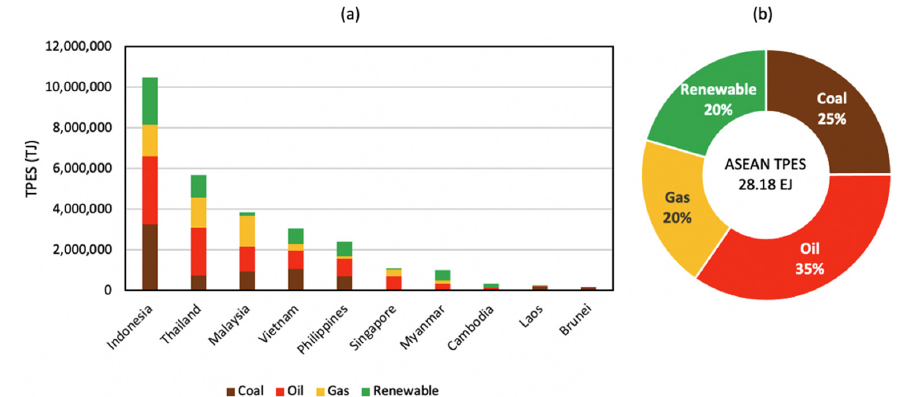
Figure 20. ASEAN TPES in 2018 by ( a ) country, and ( b ) energy type [22] .